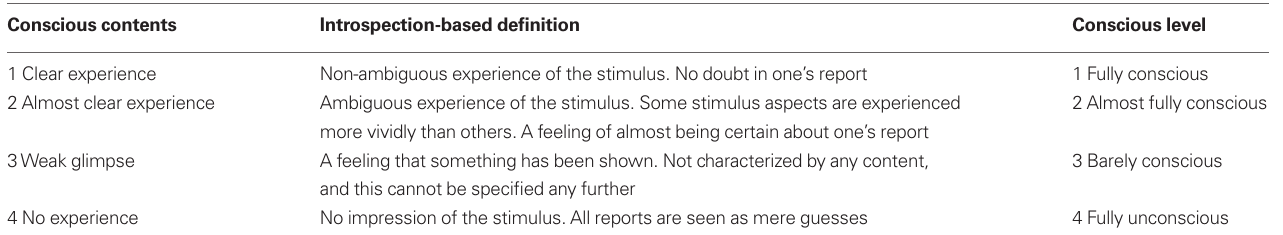
Table 2 | The relationship between categories of conscious contents and conscious levels.